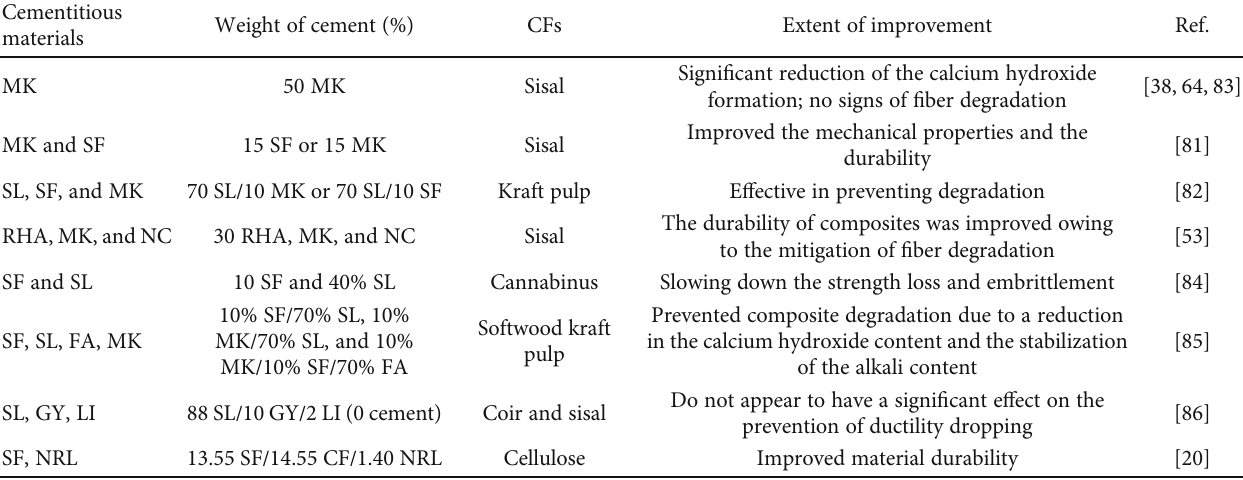
Table 5: Use of supplementary cementitious materials of CFCCs.